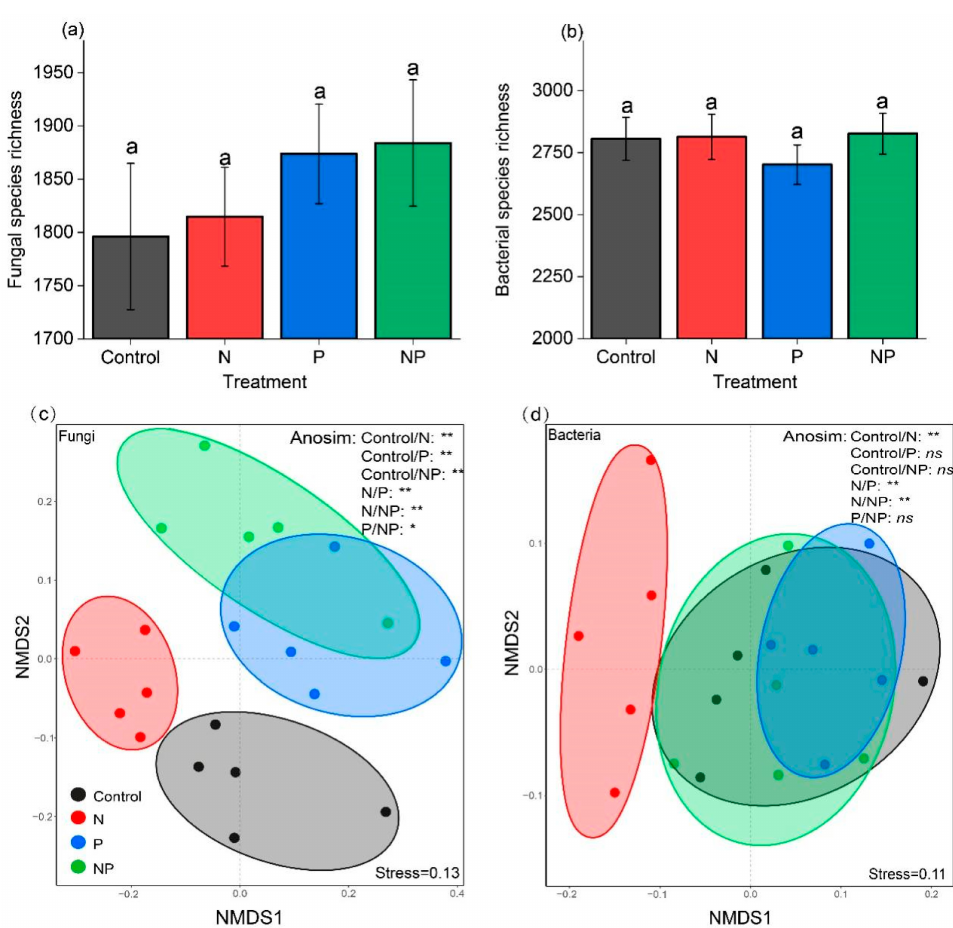
Figure 4. Effects of nitrogen and phosphorus addition on microbial species richness (M ± SE, n = 5) and community composition on operational taxonomic units (OTUs), including ( a ) fungal species richness; ( b ) bacterial species richness; ( c ) fungal community composition based on non-metric multidimensional scaling (NMDS) and analysis of similarities (Anosim) ( d ) bacterial community composition based on NMDS and Anosim. Different letters indicate that the same index has significant differences among different treatments ( p < 0.05). *, **, and ns indicated p < 0.05, p < 0.01, and p > 0.05, respectively. Abbreviations: Control, the control without any nutrient addition; N, N-alone addition; P, P-alone addition; NP, N and P together